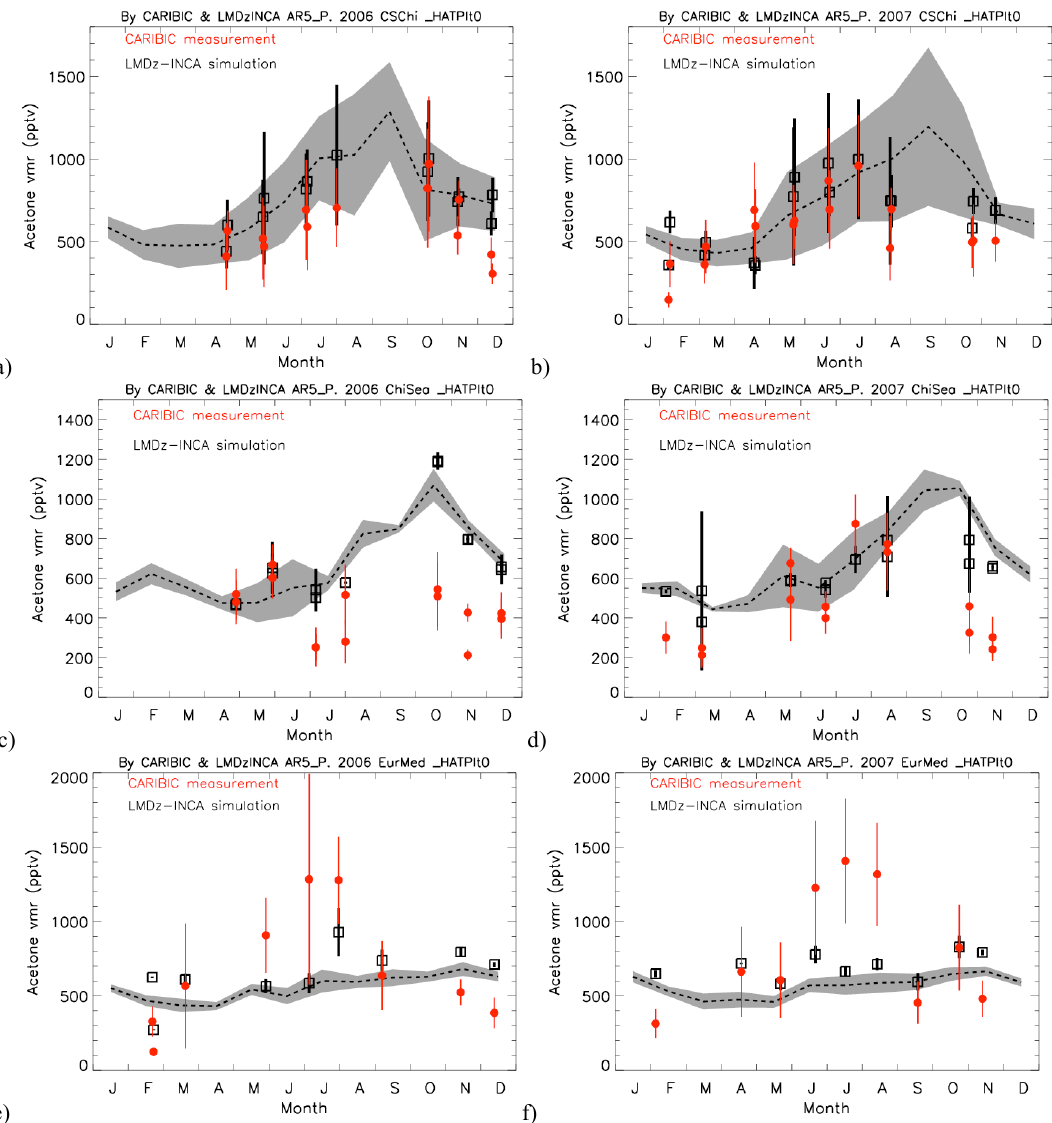
Figure 5. Annual cycle of acetone vmr (pptv) simulated and measured in 7 months of 2006 and in 9 months of 2007 in UT over Central-South China ( a and b ) and the South China Sea ( c and d ), and in 8 and 9 months of 2006 and 2007 respectively, over Europe-Mediterranean ( e and f ). Black empty squares and red filled circles present simulated and measured averages, respectively, with vertical bars for standard deviation. The intermittent line and shaded area represent the climatological annual cycle: zonal average of monthly simulations, and its standard deviation.